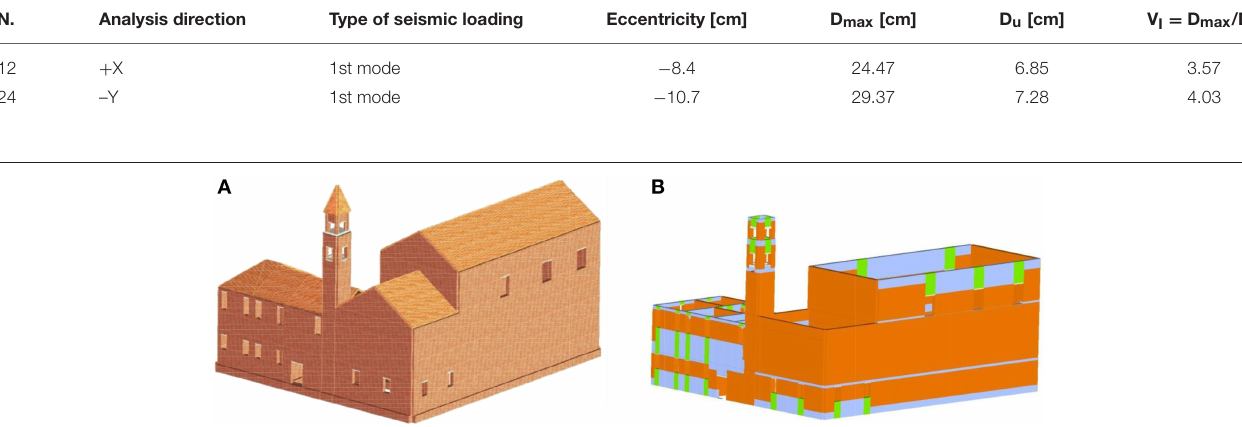
TABLE 3 | Vulnerability indexes related to the worst pushover analyses. N.